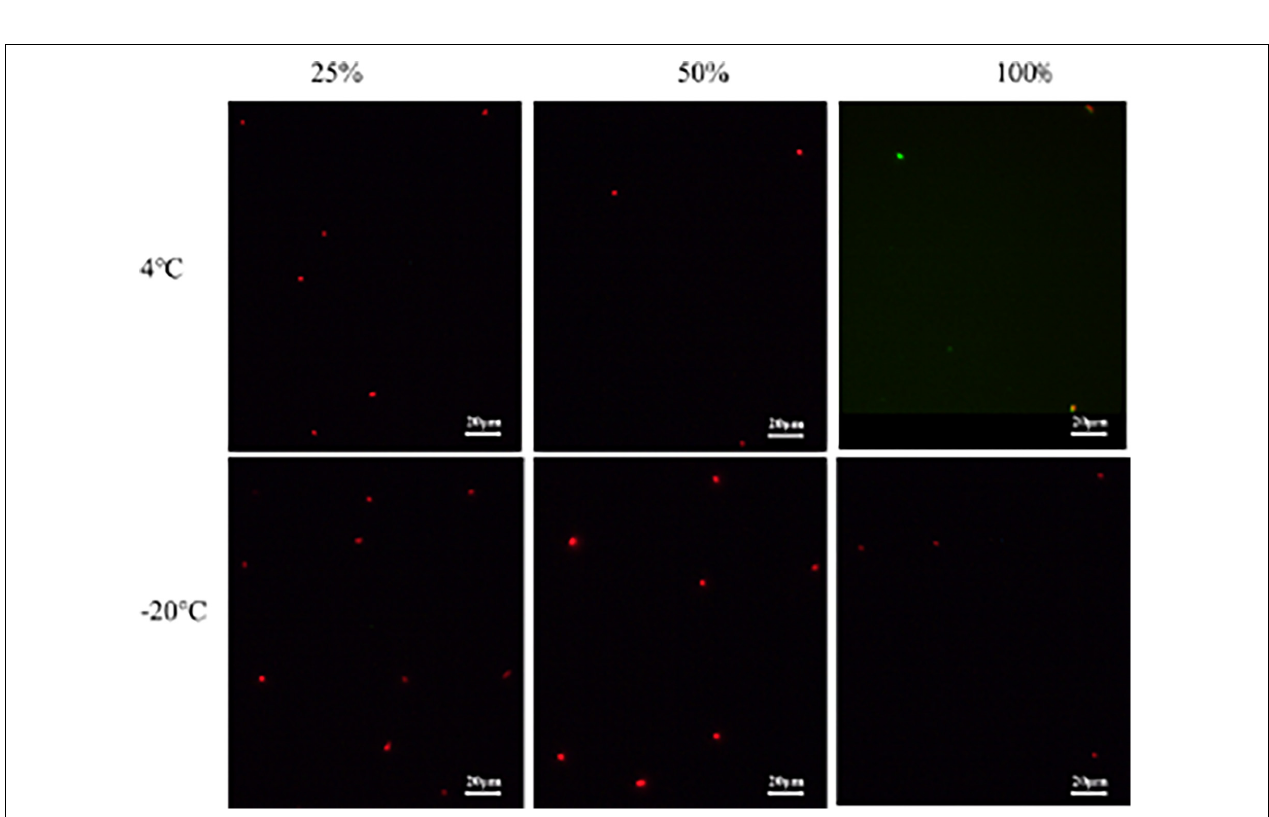
FIGURE 6 | The viability of unculturable Salmonella stored at different conditions with fluorescent observation.